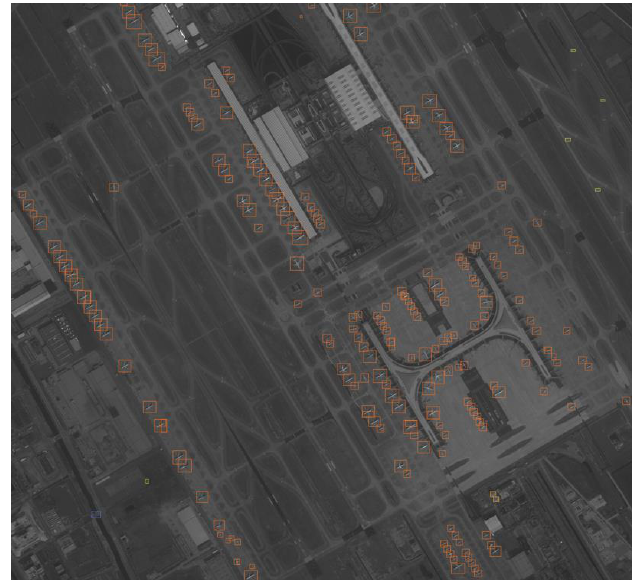
Figure 19. Detection results based on the original image.